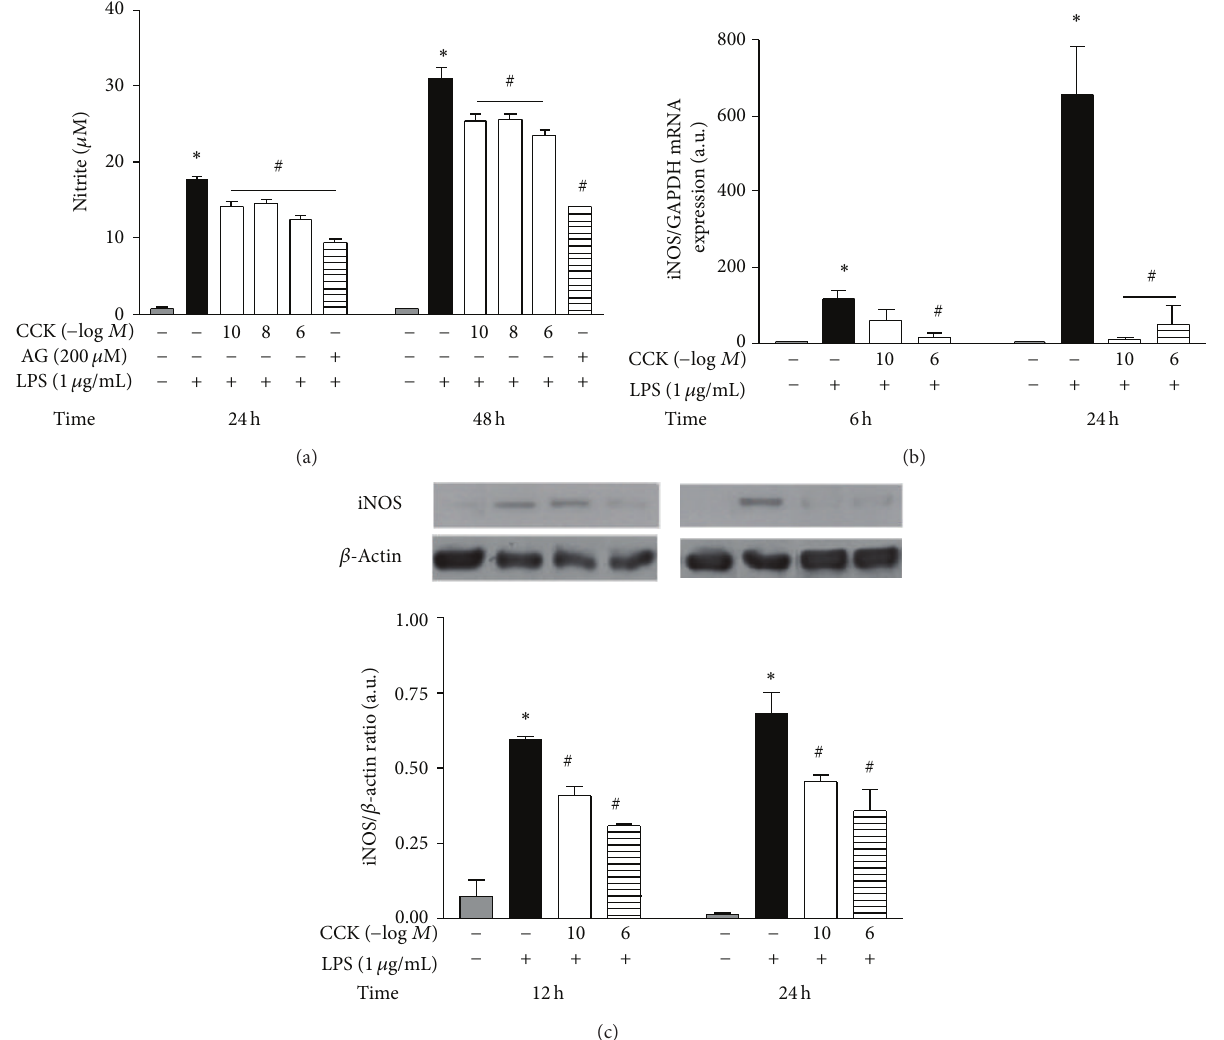
Figure 1: CCK modulates LPS-induced nitrite production and iNOS expression by peritoneal macrophages. The macrophage culture was pretreated with different CCK concentrations (10 −10 –10 −6 M) or aminoguanidine (200 𝜇 M) for 30 min before the addition of LPS (1 𝜇 g/mL) to the cell culture medium (time zero). At the indicated time-points, the culture supernatant was collected for nitritequantification by the Griess method (a), while adherent cells were harvested for iNOS expression determination. (b) Total mRNA was extracted and the expression of iNOS mRNA relative to GAPDH mRNA was analyzed by real-time PCR using specific gene primers. (c) Representative immunoblots and densitometry values (iNOS/ 𝛽 -actin ratio) of whole cell lysates. The 𝛽 -actin levels were used as an internal control. Data is a representative of five independent experiments with similar results. Values are expressed as means ± S.E.M. 𝑛 = 4 –10 samples per group. ∗ 𝑃 < 0.05 versus saline and # 𝑃 < 0.05 versus LPS